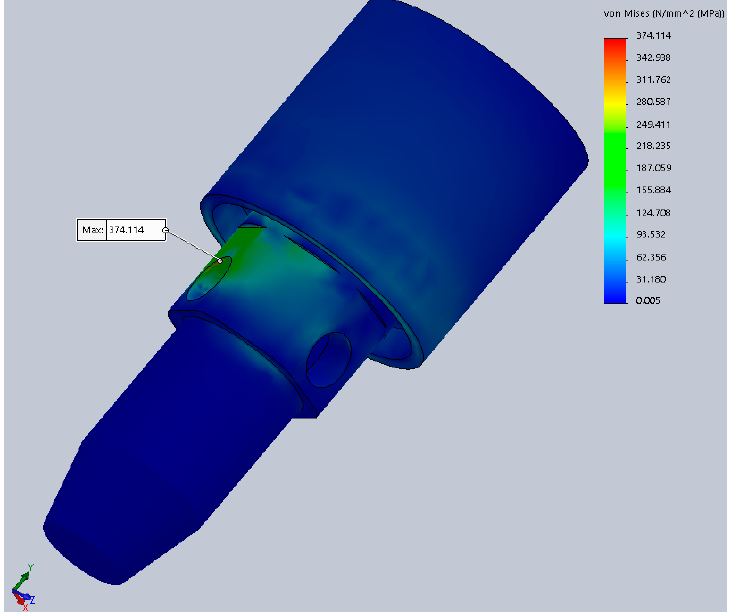
Table 3. The influence of implant placement (rotation) on the maximum stress.